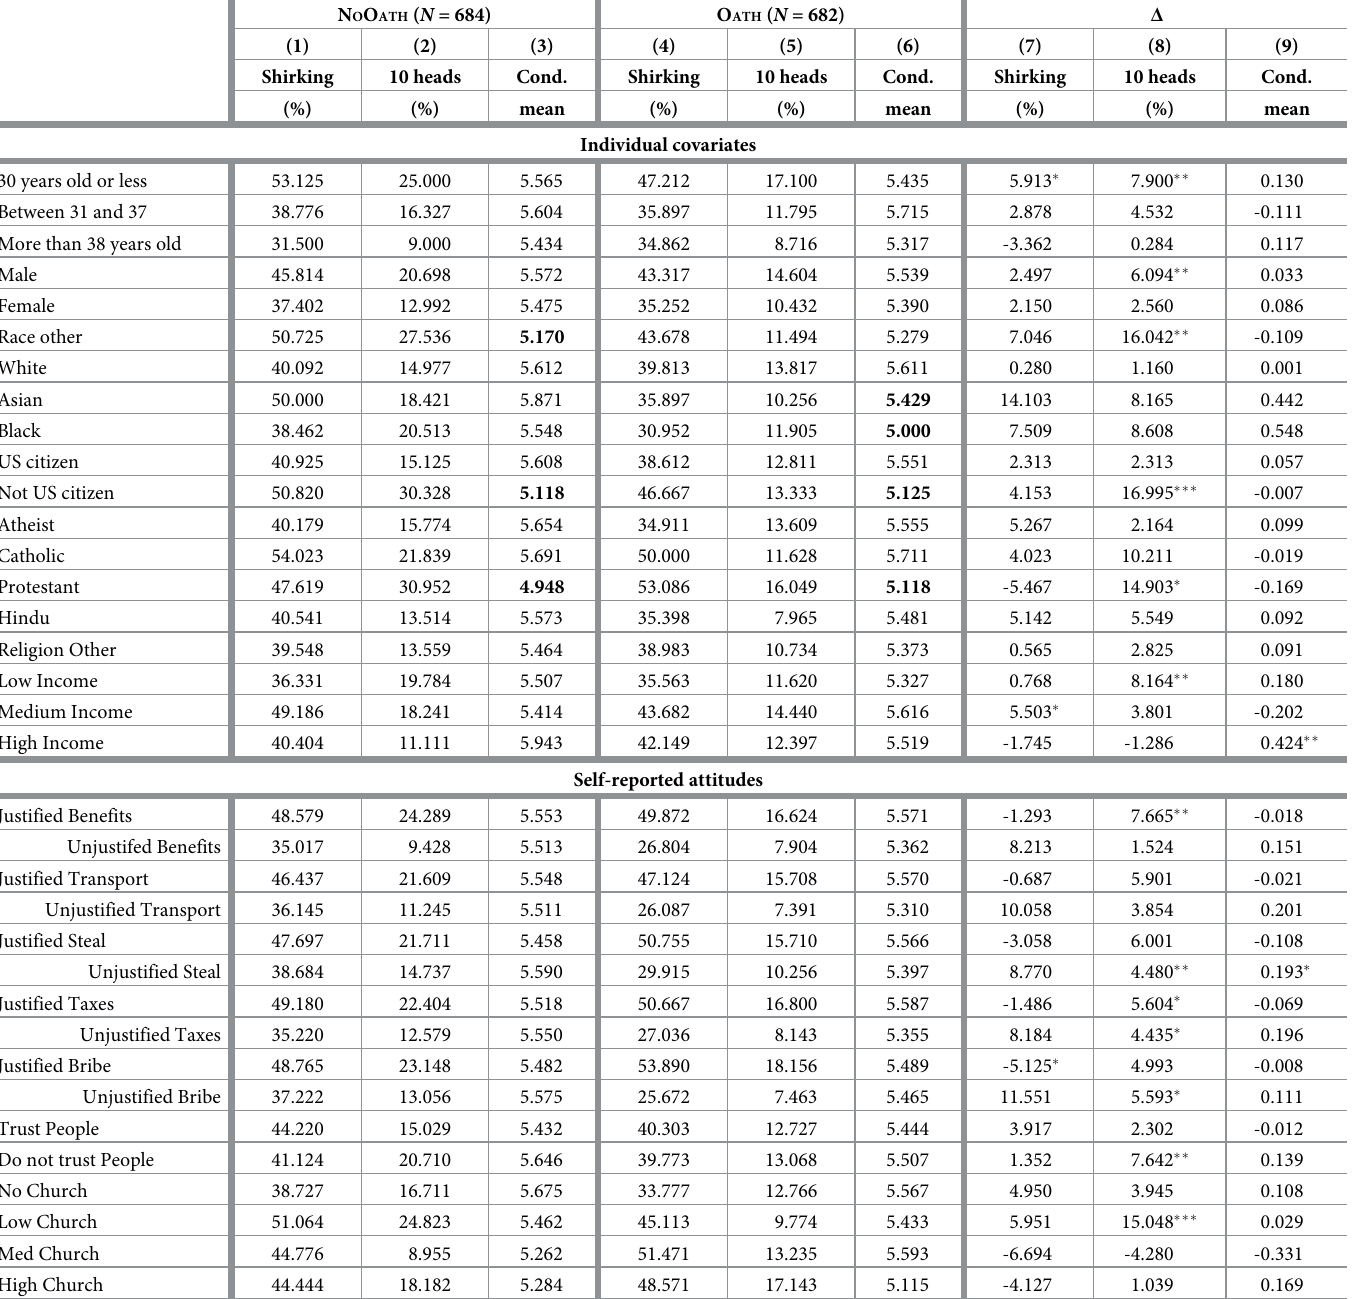
Table 4. Heterogeneity of